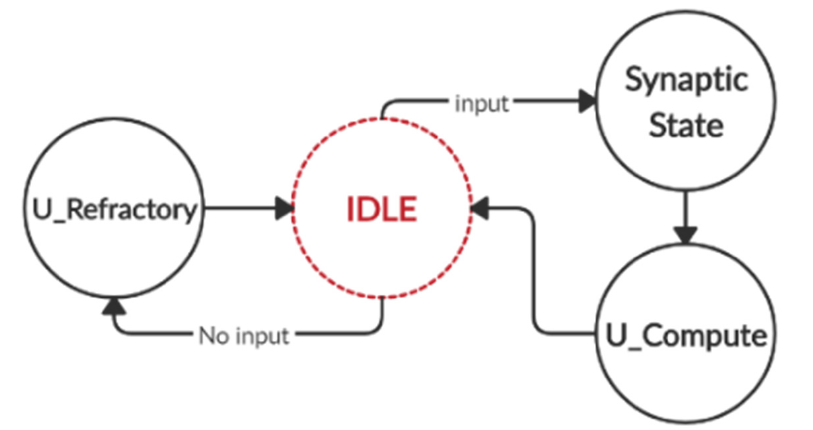
Figure 5. State diagram of the fixed-point LIF neuron.